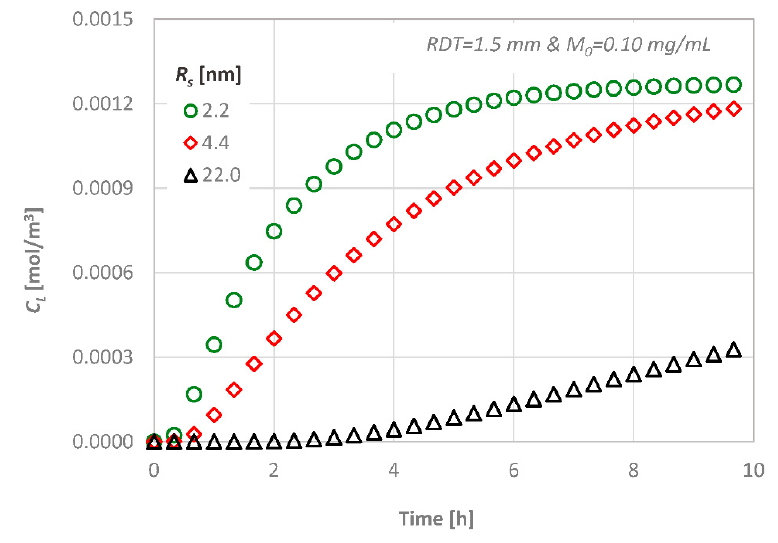
Figure 9. Effect of the molecular size on the diffusion characteristics; C L versus time.